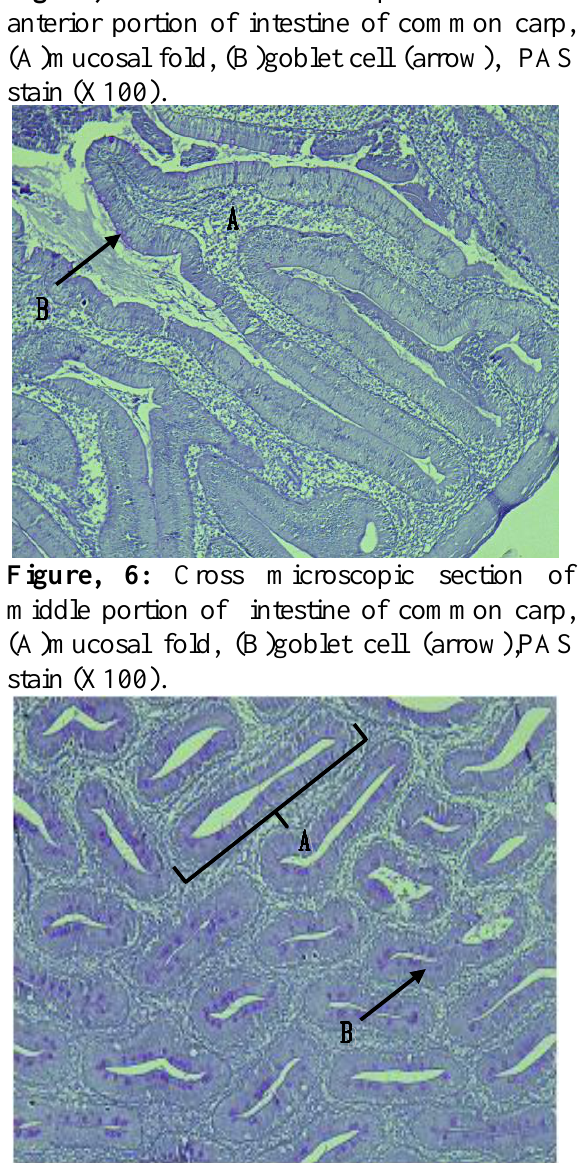
Figure , 7: Longitudinal microscopic section of anterior portion of intestine of common carp, (A)fold, (B)goblet cell (arrow), PAS stain (X400).